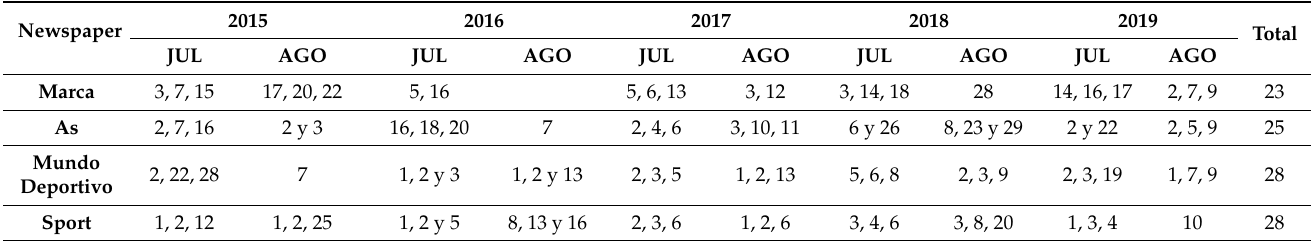
Table 3. Days chosen to be part of the sample. Compiled by author.